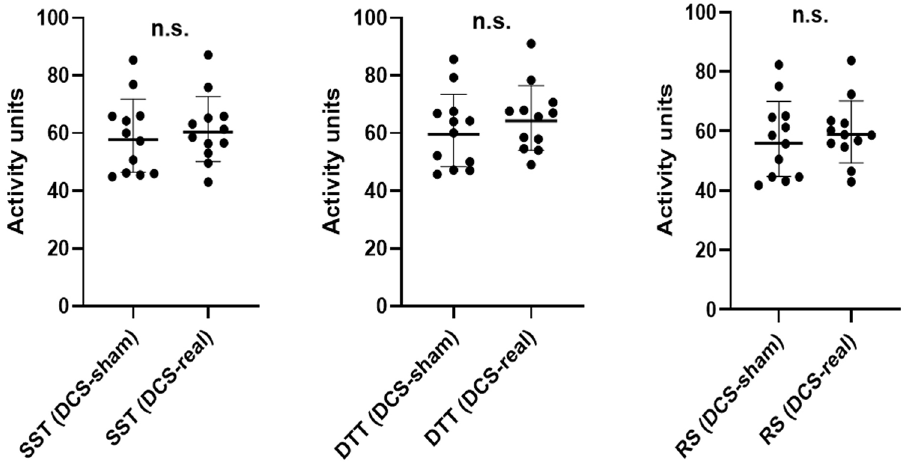
Figure 4. Dot plots representing hemoencephalography responses for the cognitive behavioral assessments and resting state (SST: Spatial span task; DDT: Double trouble task; RS: Resting